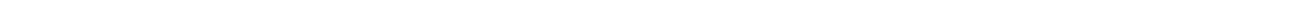
Fig. 2 PCs and BMSCs derive from the Prx1-mesenchymal lineage. a Experimental design for renal capsule transplantations. Femoral cartilages before vascular invasion were isolated from E14.5 Prx1-Cre;YFP fl / + embryos and transplanted under the renal capsule of wild-type hosts. PCs and BMSCs were isolated from mature skeletal elements 8 weeks post-transplantation as shown in Fig. 1a. b Flow cytometry analyses of PCs and BMSCs isolated from Prx1- Cre;YFP fl / + mature skeletal elements grown under renal capsule. Both PCs and BMSCs that are negative for endothelial/hematopoietic markers (CD31, CD11b, CD34, and CD45) and positive for Sca1/CD29 are mostly YFP-positive (Prx1-donor-derived) ( n = 3 per group). c Localization of Prx1-derived cells in the periosteum and fracture callus of Prx1-Cre;mTmG mouse. The un-injured periosteum is derived from Prx1-lineage (GFP + ). In the activated periosteum at day 3 post fracture, some Prx1-derived cells (GFP/pointed by green arrows) colocalize with CD29-positive cells (Merge CD29 + GFP + /pointed by white arrows). In the fracture callus (d14), all chondrocytes and osteoblasts/osteocytes are derived from Prx1-lineage (GFP + ). The fractures performed on Prx1- Cre/ERT2 , -EGFP mice, where EGFP is expressed under the Prx1 promoter, show no GFP signal in the callus. d Experimental design for cell-lineage analyses of Prx1-derived cells during bone regeneration in renal capsule. Femoral cartilages were isolated from E14.5 Prx1-Cre + / − ;LacZ fl / + embryos and transplanted under the renal capsule of wild-type hosts. After 8 weeks, mature femurs underwent osteotomy and were collected at d14 post-fracture for cell-lineage tracing. e TC and Xgal/TRAP double-staining on longitudinal sections of Prx1-Cre + / − ;LacZ fl / + fractured femurs in wild-type hosts (top) showing new bone within the callus entirely donor-derived, i.e., LacZ + TRAP − (black arrowheads: osteocytes) and some osteoclasts (TRAP + LacZ + with endogenous beta- galactosidase activity). Scale bar: 0.5 mm. TC: Masson ’ s trichrome, TRAP: Tartrate resistant acid phosphatase, m: muscle, c: cortex, po: periosteum, bm: bone marrow, cal: callus, ca: cartilage, white dashed line: callus, orange lightning bolt: fracture, orange arrow: fracture site, black arrow: points to the periosteum, black arrowhead: osteocytes in new